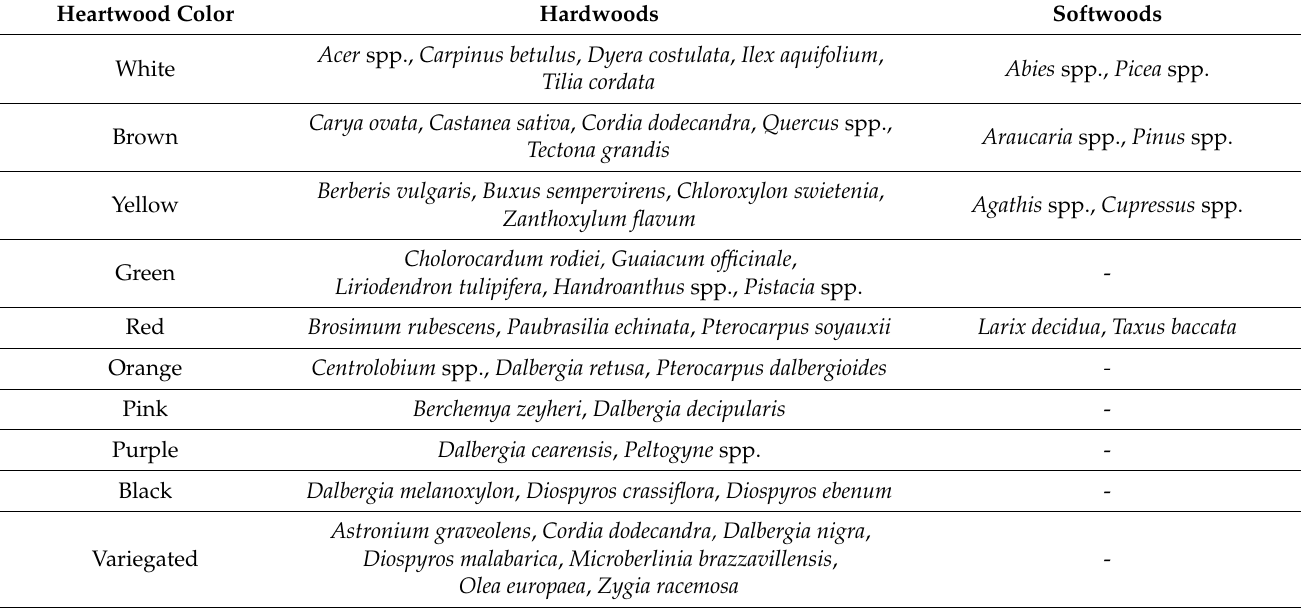
Table 4. Examples of species for different heartwood colors. Heartwood Color Hardwoods Softwoods